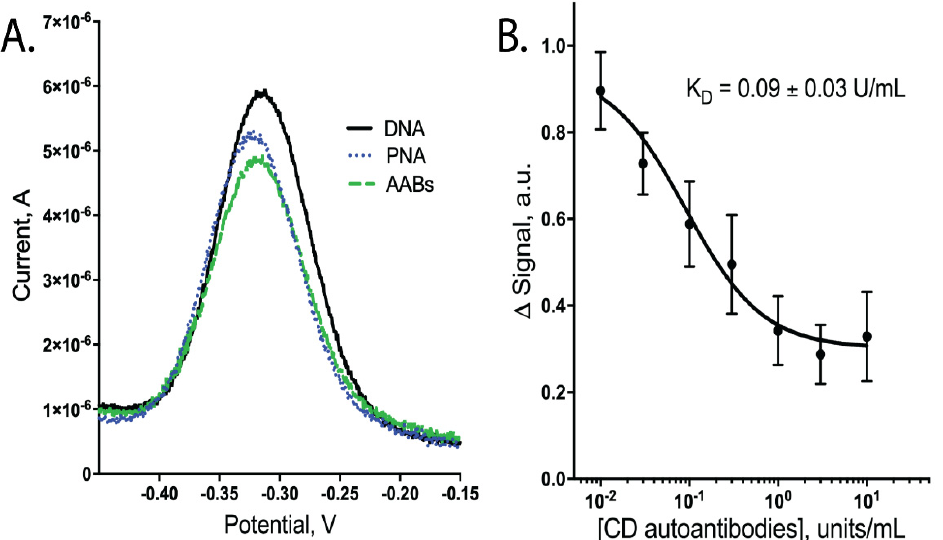
Figure 2. Binding performance of biosensors when tested with CD AABs in binding buffer (1 × PBS with 1 mM MgCl2, 0.05% Tween 20, pH 7.4). ( A ) Square-wave voltammogram showing a decrease in peak current; signal in ( B ) calculated by change in peak height following PNA binding vs. addition of AABs. ( B ) Dose-dependent curve of signal change (arbitrary units) vs. CD AAB concentra- tion with apparent dissociation constant (K D ) of 0.09 ± 0.03 units/mL ( n = 6; errors bars are SEM).